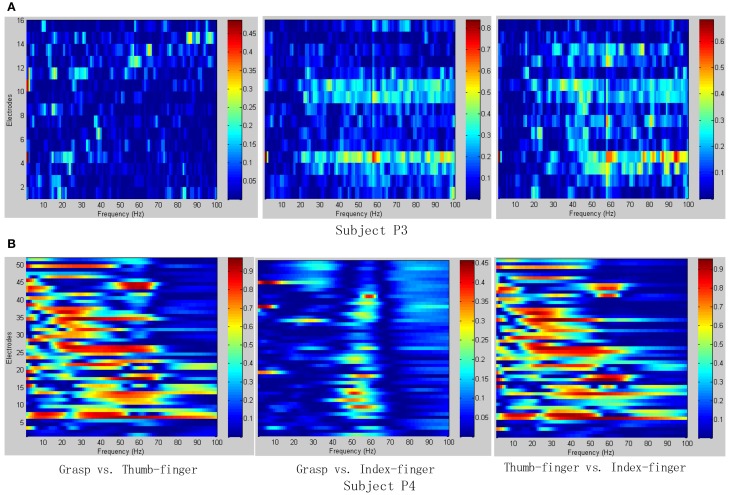
R2-values for Subject P3 and P4 with two different combinations of classes (Grasp vs. Thumb-finger, Grasp vs. Index-finger, Thumb-finger vs. Index-finger) during awake craniotomy. The power spectrum shown here was calculated with a frequency bin width of 1 Hz for each electrode. The selected frequency bins of P3 with combination of Grasp and index-finger, for example, were 64, 65, 97, 98, 99 within electrodes 3, 4, 9, 10, 16. And similarly, the selected frequency bins of P3 with combination of thumb-finger and index-finger were 2, 14, 18, 35, 65 within electrodes 4, 11, 12, 13, 14. (A)
R2-values of Subject P3; (B)
R2-values of Subject P4.